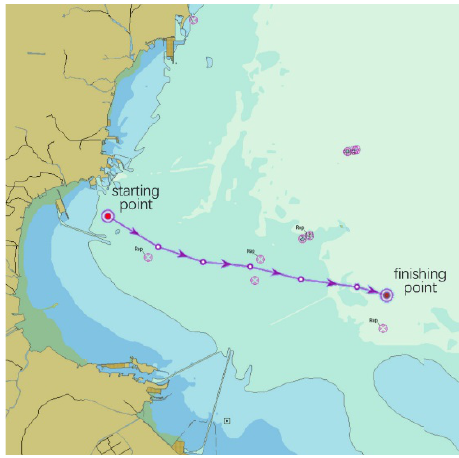
Figure 6. The customary route by ship master.